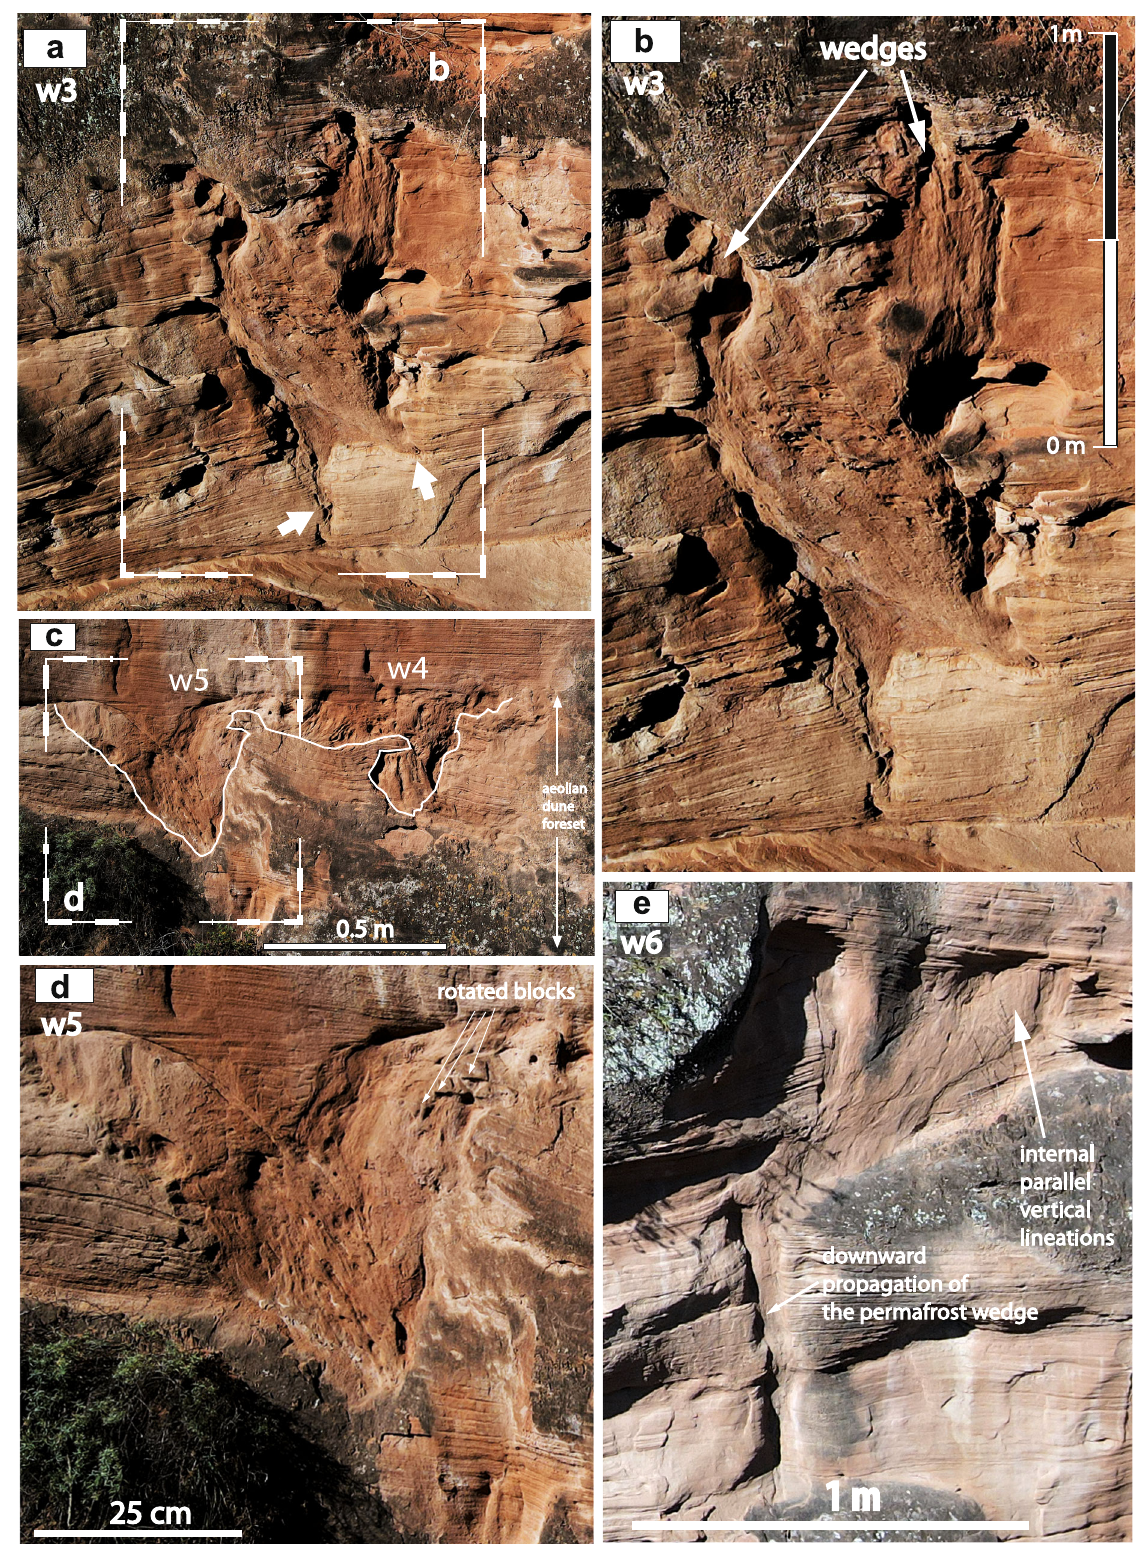
Fig. 2 | Sedimentology of sandstone wedges in the aeolian dunes of the Luohe Fm. SeelocationofwedgesinFig.1candSupplementaryFig.5b. a Wedgew3,white arrows mark the termination of the wedge toes in the cross-bedded aeolian dune sandstones. b Close-up view from a showing two wedges and their downward terminations. c Wedges w5 and w4, and d close-up view from c , showing rotated